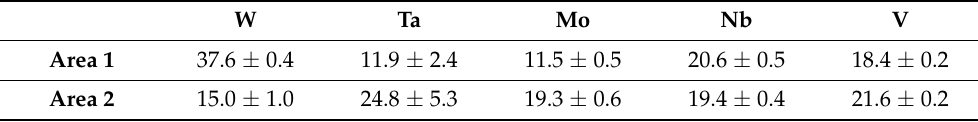
Table 6. Local chemical compositions (at. %) by EDS analysis, related to Figure